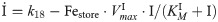
Iron storage during high-affinity uptake.(a) The model is an extension of that in Fig 6a containing in addition inflow controller molecule I inside the vacuole which activates a transporter located in the vacuolar membrane. Controller molecule I is subject to an iron-dependent degradation. The rate equation for I is: I˙=k18-Festore·VmaxI·I/(KMI+I) (b) Calculation showing the increase of iron in the vacuole, Festore, as a function of time. The iron set-point inside the vacuole is given by Eq (31) and set to 700.0. The flux of iron entering the vacuole due to controller I is given as: jIFe-store=k17·Fecyt·I. The additional parameter values are: k17 = 1 × 10−3, k18 = 700.0, VmaxI=1.0, KMI=1×10-4. Other parameter values and initial concentrations as in Fig 6. The initial concentration of controller I is zero.